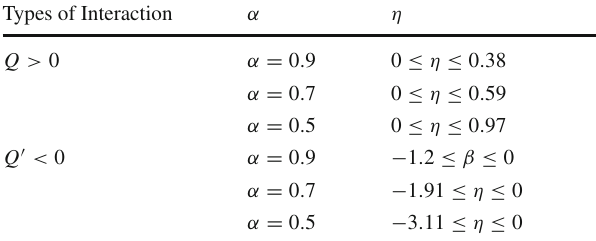
Table 4 Cosmological parameter values at the present epoch for Q < 0, with exponential and linear interaction Parameter Exponential interaction Linear interaction